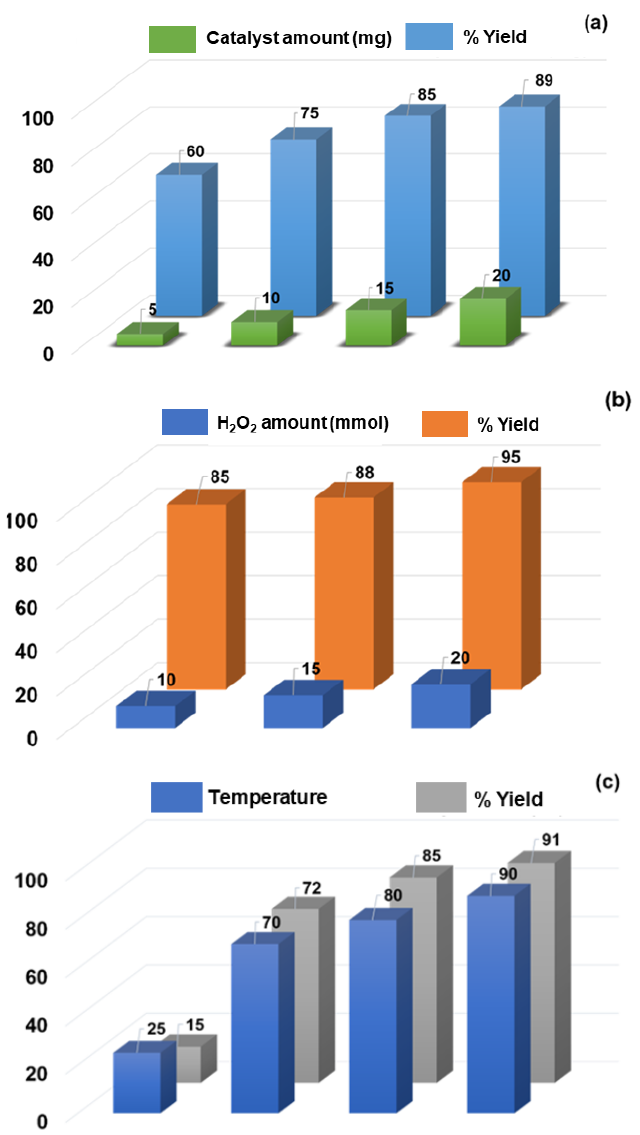
Figure 5. ( a ) Effect of different amounts of catalyst 2 (0.005, 0.010, and 0.015 g) on the yield using 30% aqueous H 2 O 2 (1.13, 0.010 mol) at 80 °C. ( b ) Effect of different amounts of oxidant, i.e., 30% aqueous H 2 O 2 (0.010, 0.015, and 0.020 mol), on the yield using catalyst 2 (0.0150 g) at 80 °C. ( c ) Effect of temperature variations (RT, 70, 80, and 90 °C) on the yield using catalyst 2 (0.0150 g) and 30% aqueous H 2 O 2 (0.010 mol).